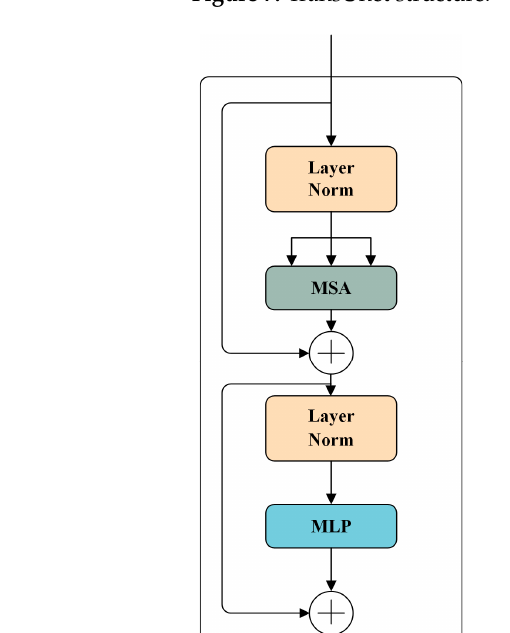
Figure 7. TransUnet structure.